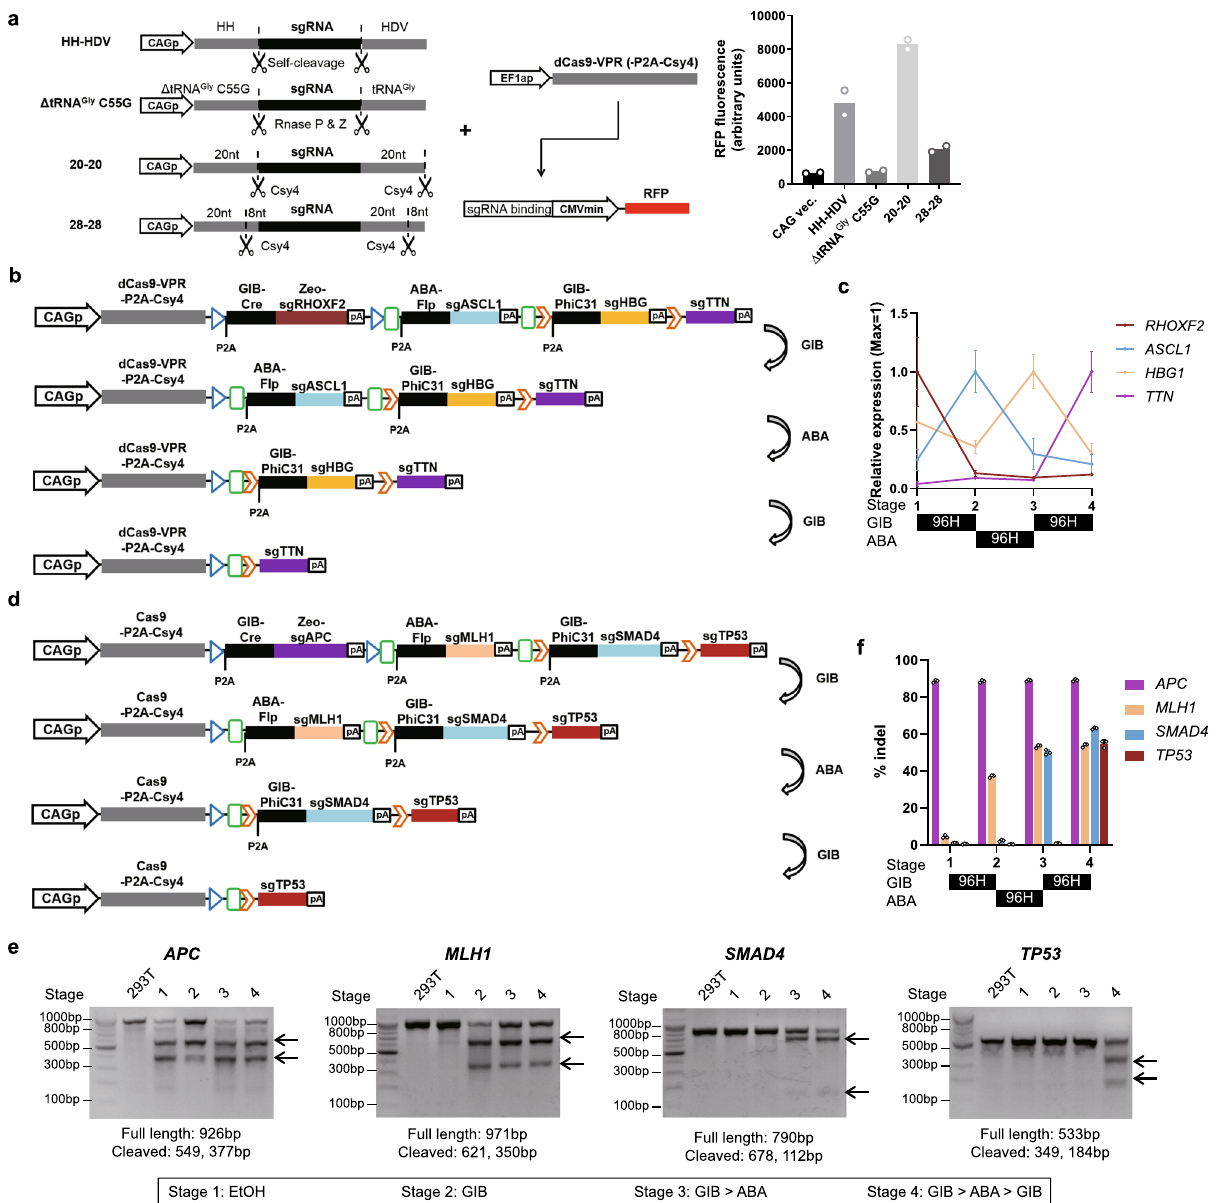
Fig. 3 Sequential transcriptional cascade and gene editing by tandem-GPC-CRISPRa and tandem-GPC-CRISPR, respectively. a (Left) Schematics of different architectures for RNA Pol II-driven sgRNA expression and reporter construct for sgRNA activity. (Right) Activity of RFP sgRNA reporter with indicated RNA Pol II-driven sgRNA format ( n = 2, values indicate mean). EF1ap: human EF1a promoter, CMVmin: minmal CMV promoter. b Tandem GPCv2-CRISPRa schematics. c Quanti fi cation of sgRNA target genes after each indicated sequence of ligand treatment ( n = 3, mean ± s.d.). d Tandem GPCv2-CRISPR schematics. e Validation of sequential gene mutations using T7 endonuclease assay. Arrows indicate cleaved bands. The expected lengths of uncleaved, and cleaved bands are noted below the gel image. f Quanti fi cation of gene editing in e by next generation sequencing (NGS) ( n = 3, mean ± s. d.). Source data are provided as a source data fi